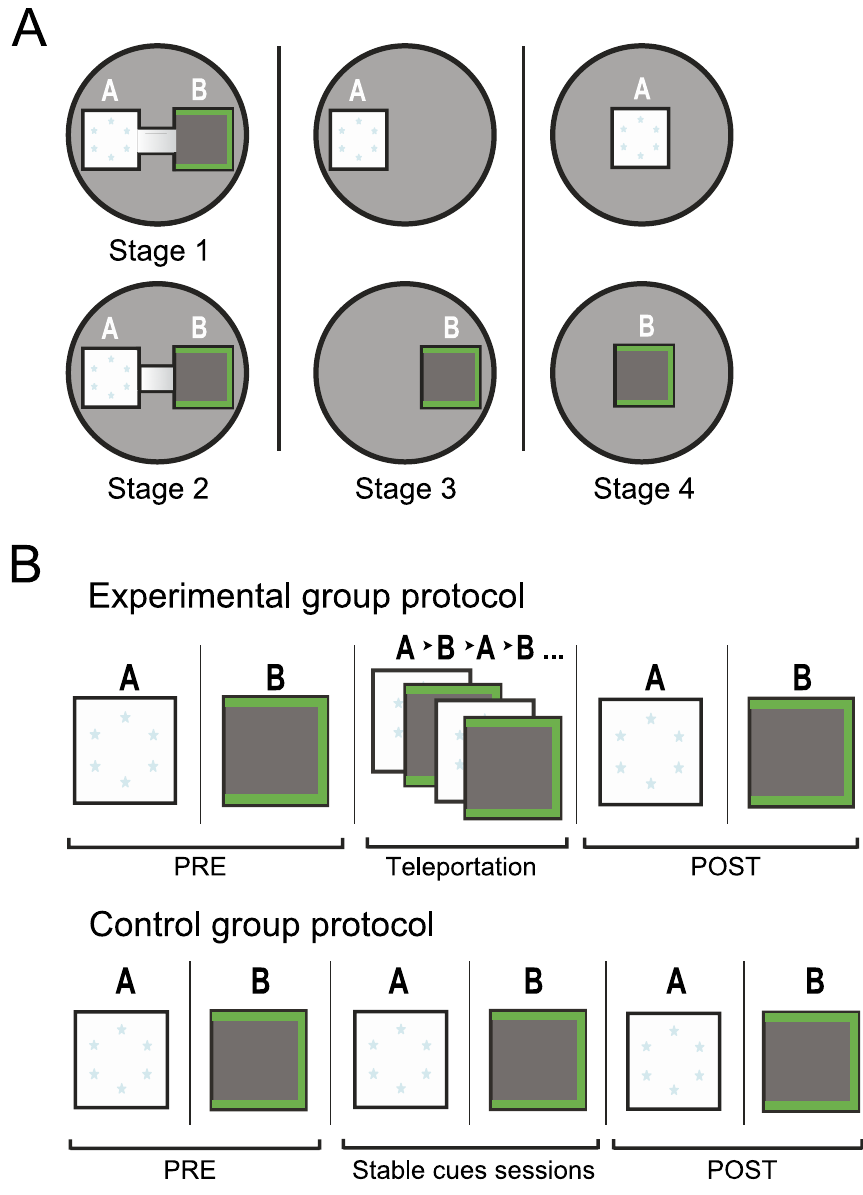
Figure 1. Scheme of the training and experimental paradigm. ( A ) All procedures were performed in an enclosure surrounded by black curtains. The training scheme was designed so that the animal forms two distinct spatial representations for the respective environments. ( B ) Scheme of the experimental day procedure. Initial baseline recordings (PRE) were followed with the teleportation session in the experimental group or with two sessions with steady cues in controls. After 20 and 50-min, two test sessions (POST) were